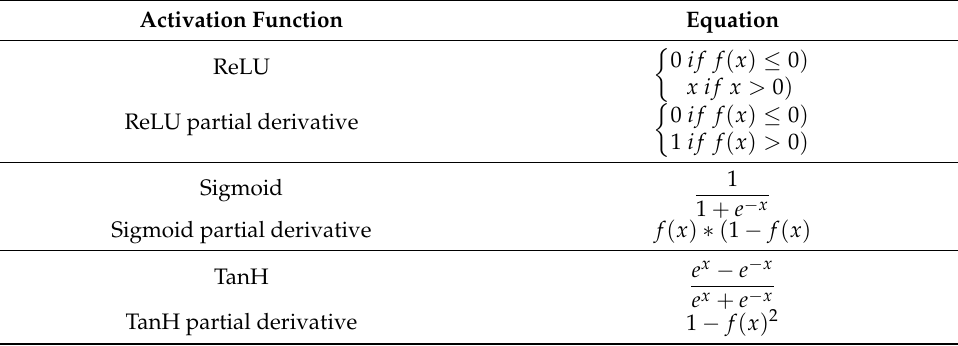
Table 3. Activation functions supported by